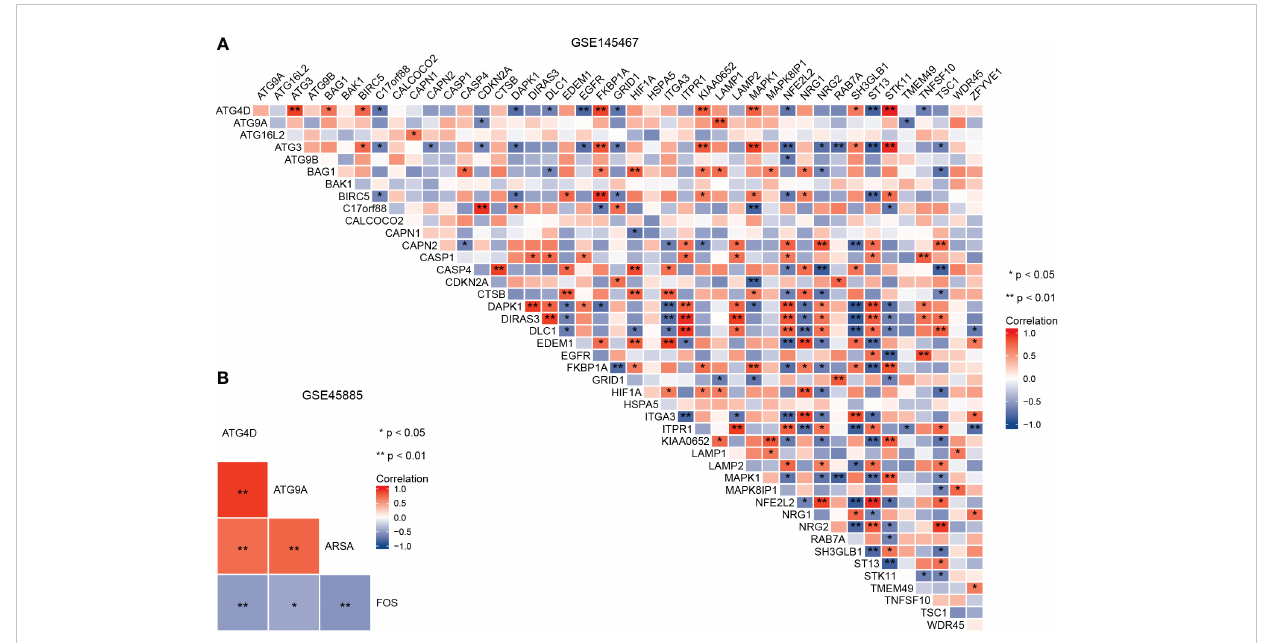
FIGURE 3 Correlation heatmap of autophagy-related differentially expressed genes in GSE145467 (A) and GSE45885 (B)